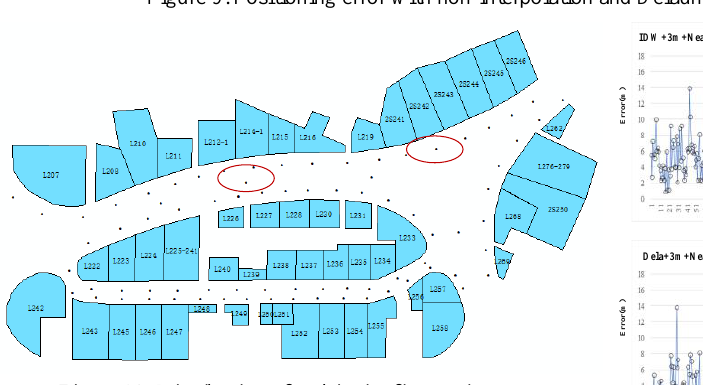
Figure 10. Distribution of ambiguity fingerprints.